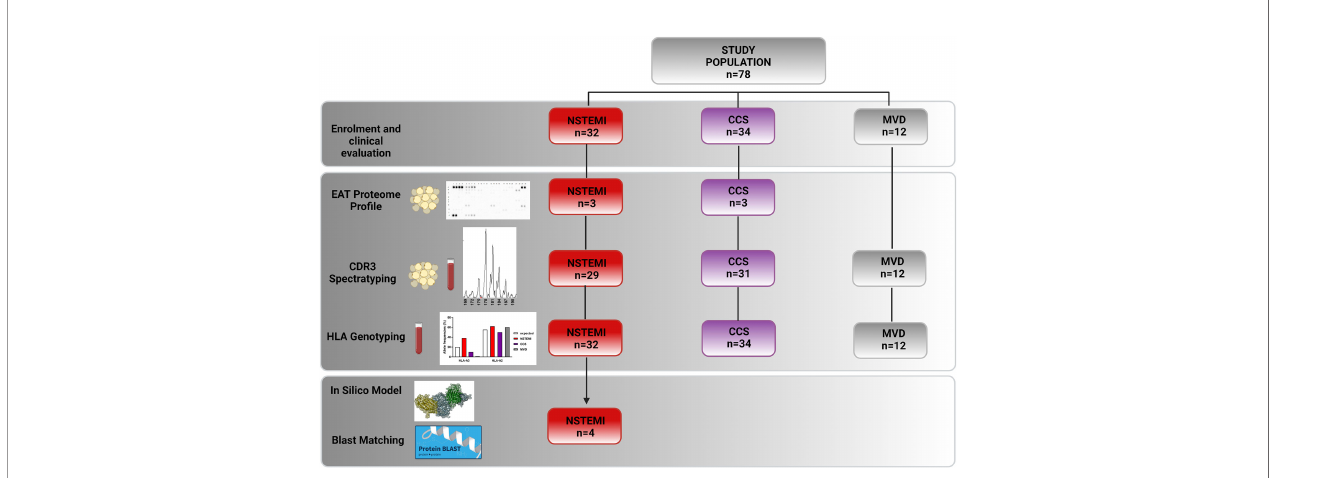
FIGURE 1 | Flowchart showing enrolled patients and their experimental and study result allocations. We obtained EAT biopsies and peripheral blood from 32 NSTEMI patients, 34 CCS patients, and 12 MVD patients undergoing surgery. Three EAT specimens from NSTEMI and CCS patients were used for proteome pro fi ling. We therefore performed TCR spectratyping and CDR3 sequencing in EAT and PBMCs of 29 NSTEMI, 31 CCS, and 12 MVD patients. We performed HLA-A molecular typing from DNA extracted from the PBMCs of the same patients. Twelve NSTEMI patients showed a TRBV21 perturbation, four of which shared a distinctive TRBV21-CDR3 sequence of 178 bp length and 2/4 were carriers of the human leukocyte antigen (HLA)-A*03:01 allele. We then used computational 3D modeling studies to predict interactions between HLA-A3*01 and the TRBV21-CDR3 sequence of 178 bp length, employing BLAST to compare the predicted peptide sequence to speci fi c microbial databases. BLAST, Basic Local Alignment Search Tool; EAT, epicardial adipose tissue; HLA, human leukocyte antigen; MVD, mitral valve disease; NSTEMI, non-ST elevation myocardial infarction; PBMC, peripheral blood mononuclear cells; CCS, chronic coronary syndrome; TCR, T-cell